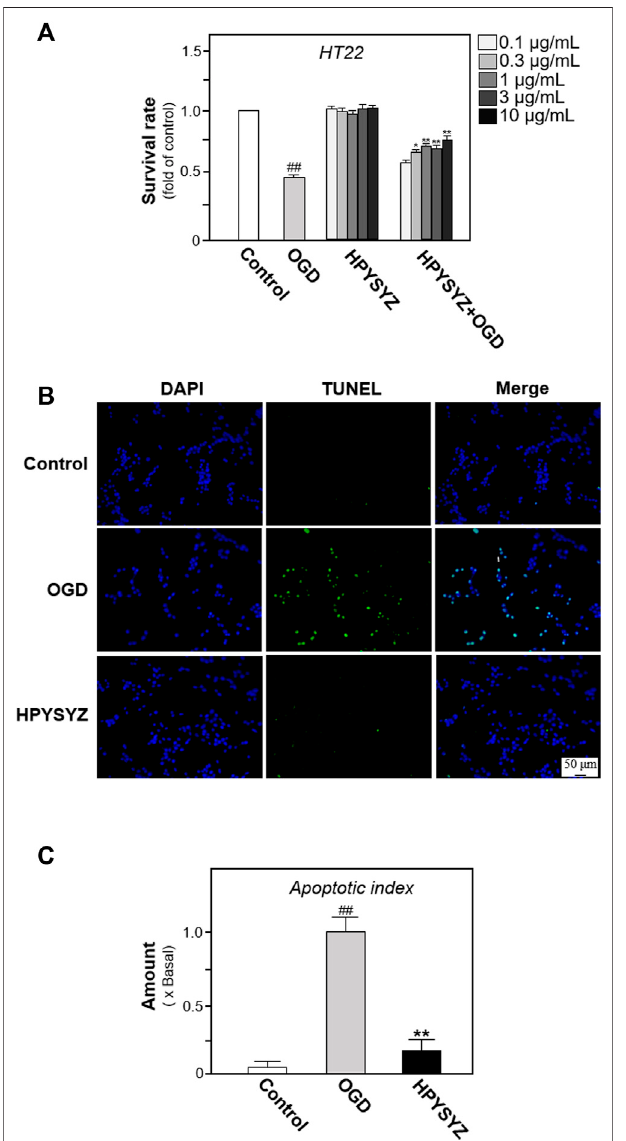
FIGURE9| Ethylacetate extracts ofsuccinumdecreasedtheapoptosis of HT22 cells under OGD condition. (A) HT22 cells were treated with ethyl acetate extracts of succinum (HPYSYZ) from 0.1 μ g/ml to 10.0 μ g/ml for 48 h under OGD condition, and cell viability was determined by MTT assay. (B) TreatmentofHT22cellswassameasthatin (B) andtheTUNELassaywas applied for evaluation of cell apoptosis. The representative images of the control group, OGD model group, and HPYSYZ treatment (10 μ g/ml) are displayed. (C) Percentage of TUNEL-staining positive cells to DAPI-staining positivecellswascalculatedforapoptosisevaluation.Valuesareexpressedas the percentage of the control group as mean ± SEM ( n = 8). Comparisons between groups were carried out by a one-way ANOVA followed by a post hoc Bonferroni test. # p < 0.05 (compared with control group); * p < 0.05, and ** p < 0.01 (compared with the OGD model group).